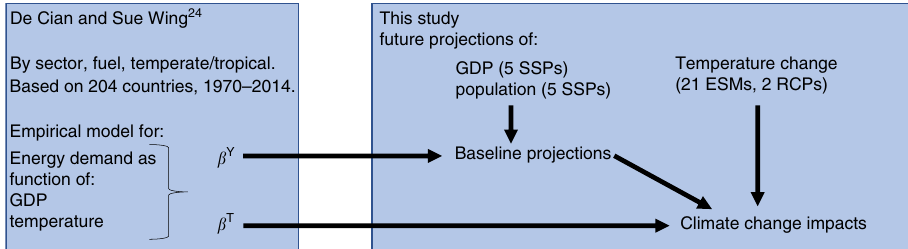
Fig. 6 Brief overview of the methodology of this study and its relation to De Cian and Sue Wing (2018). De Cian and Sue Wing (2018) estimated elasticities of energy use with changes in temperature ( β T ) and GDP per capita ( β Y ). This study combines these elasticities with GDP and population projections for the SSPs to establish baseline projection and with temperature projections from 21 climate models to analyze climate change impacts